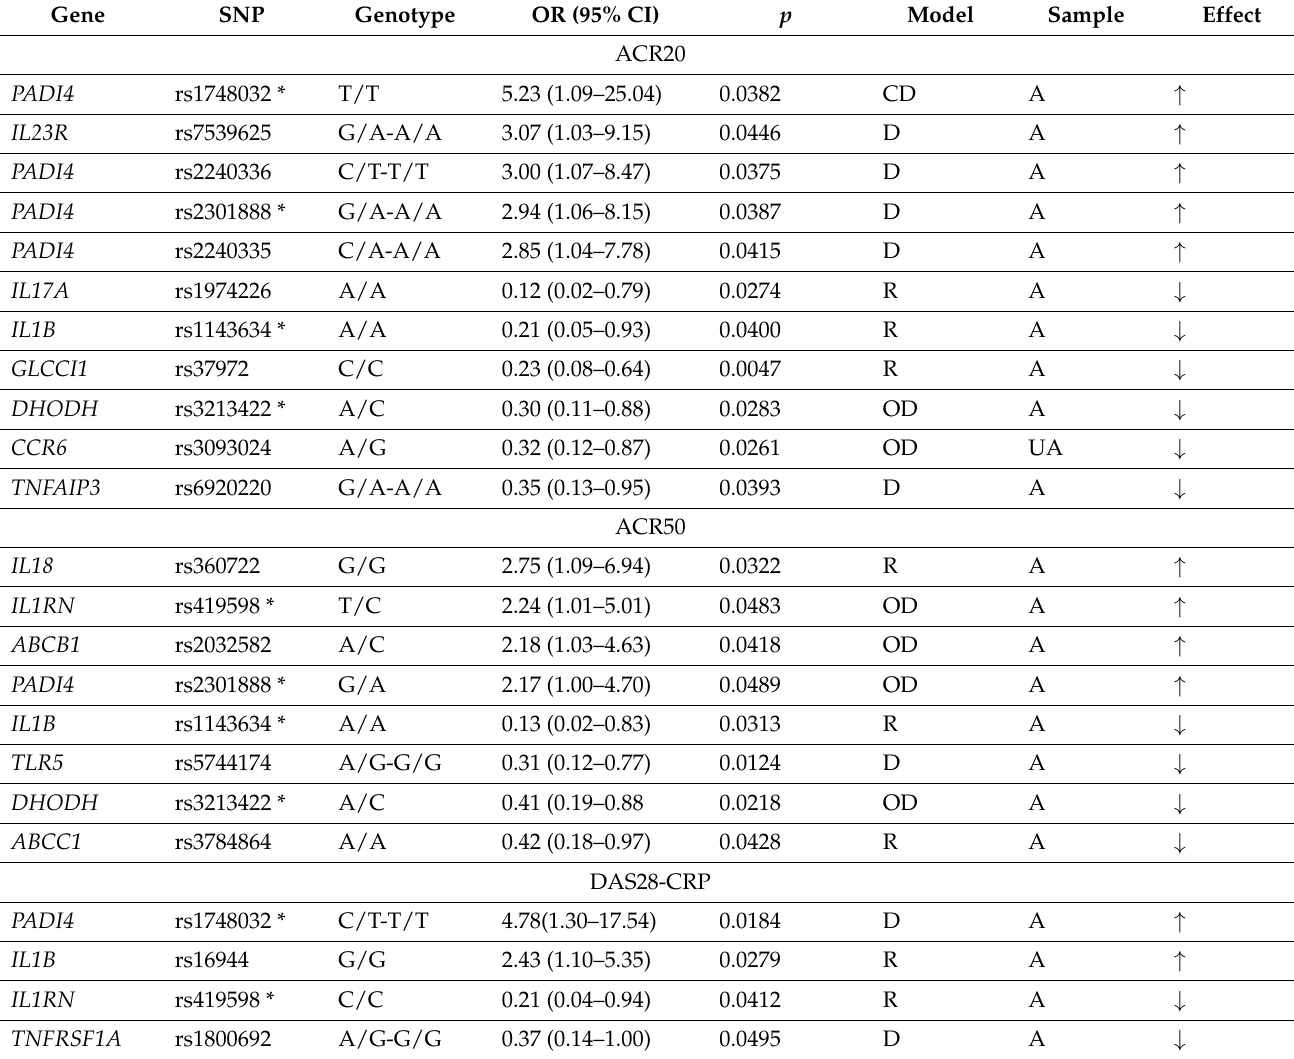
Table 2. Associations of polymorphic variants with the efficacy of olokizumab treatment at week